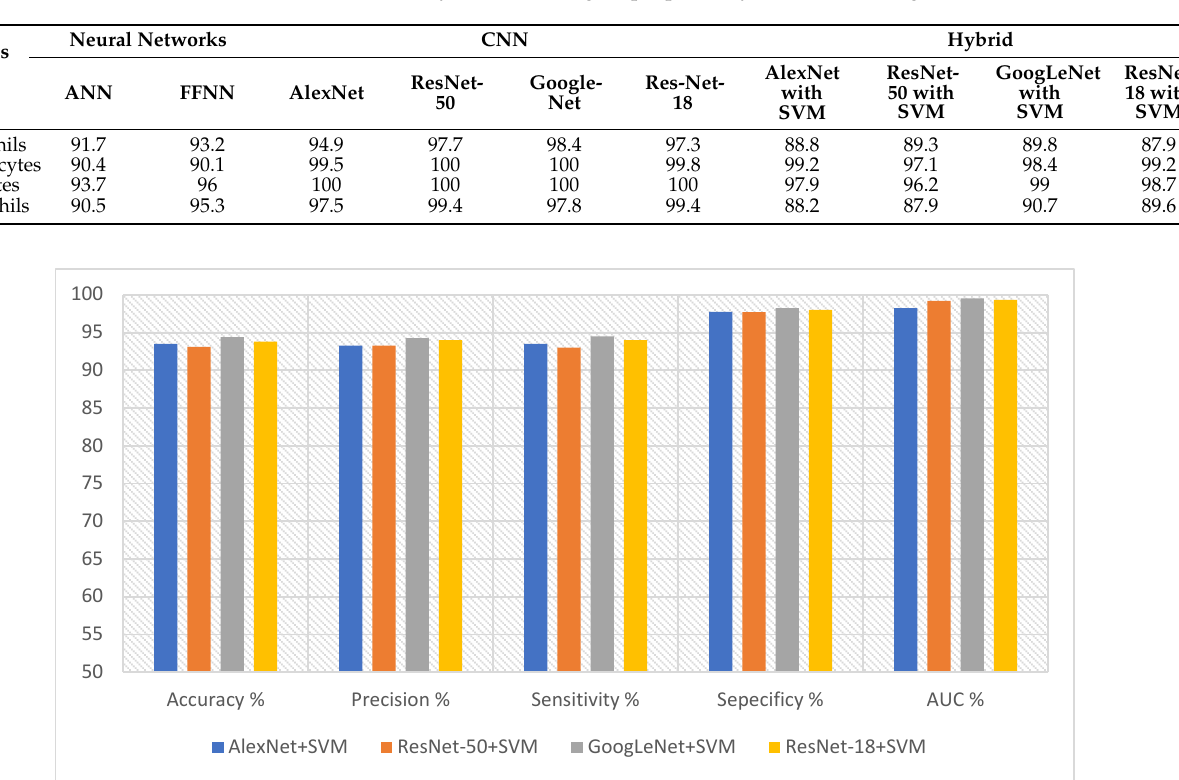
Table 7. Results from the implementation of the proposed methods compared to those of relevant studies.